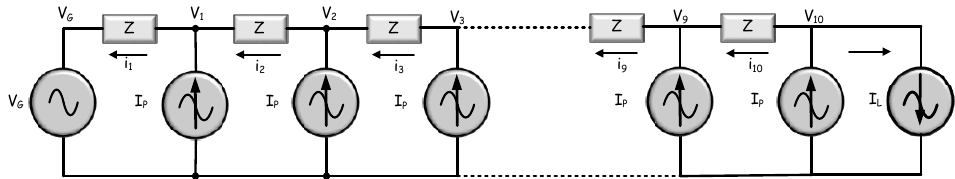
Figure 3. Equivalent circuit of a massive connection of photovoltaic systems with the power- consumer.